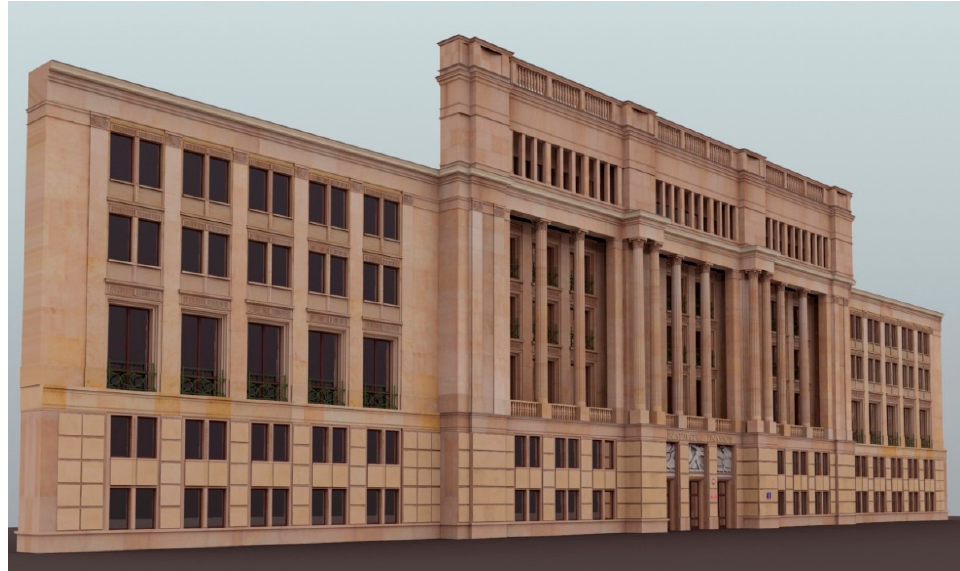
Figure 3. Rendering showing the correctly defined reflectance and transmittance factors of materials used in the object, with the use of daylight.